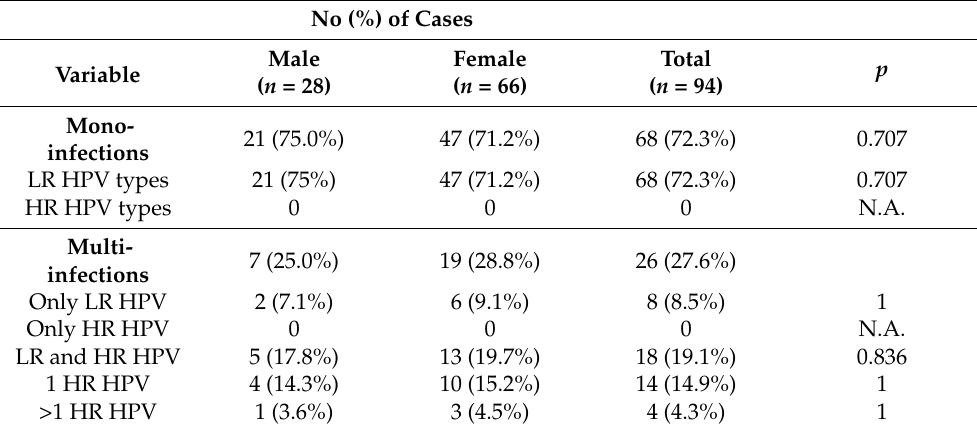
Table 2. Prevalence of human papillomavirus (HPV) infection in external anogenital warts (EGW), according to low-risk (LR) and high-risk (HR)